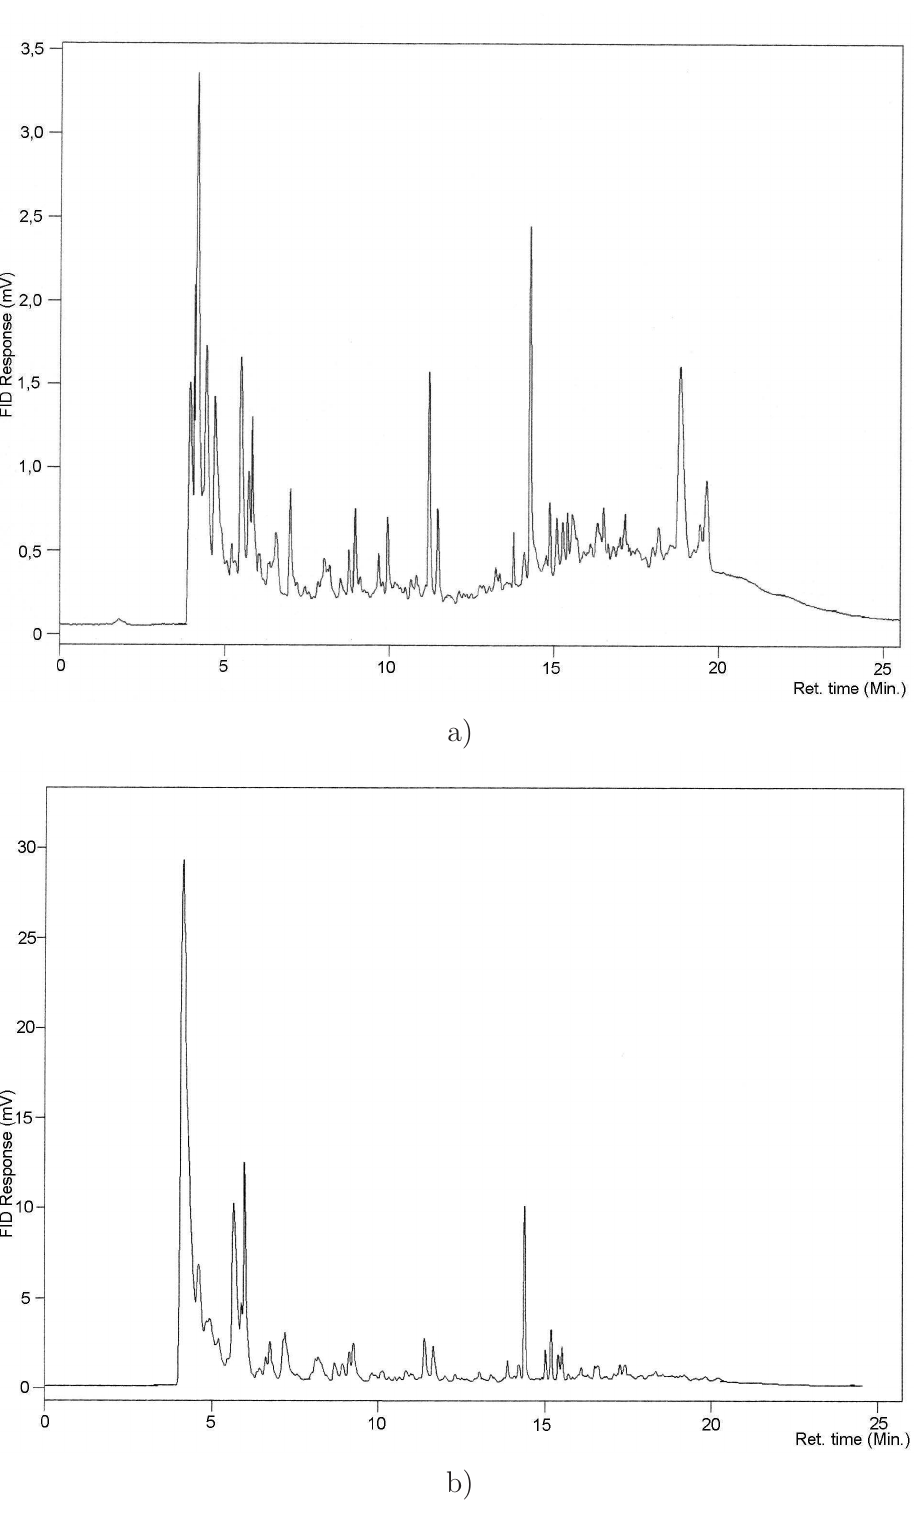
Fig. 1 Pyrogram of Algae ( Chlorella kessleri ) obtained by Py-GC analysis: a) pyrolysis temperature 600 ◦ C; b) pyrolysis temperature 700 ◦